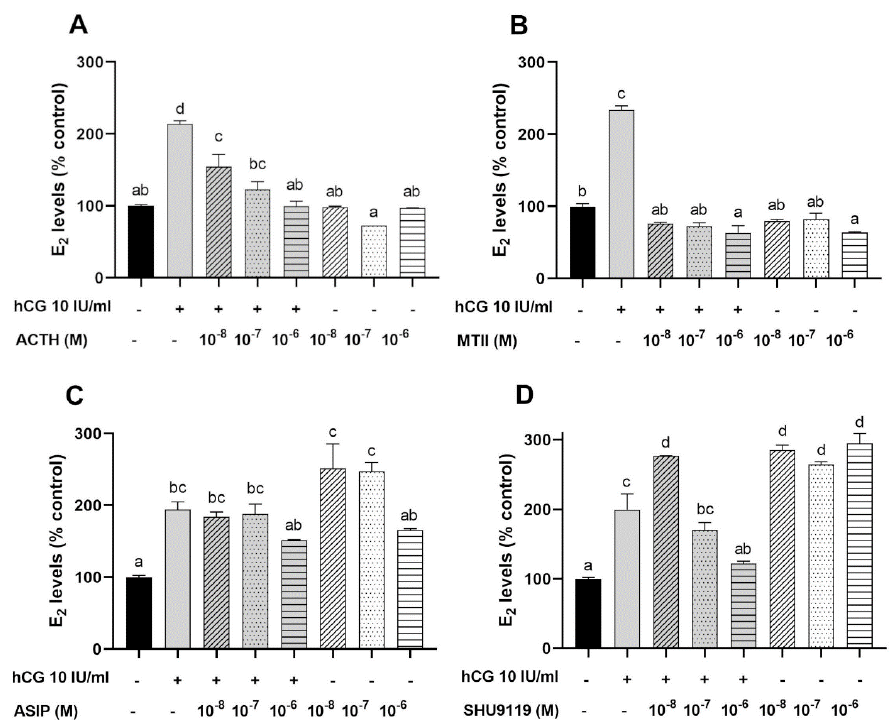
Figure 4. Effects of melanocortin peptides on basal and human chorionic gonadotropin (hCG)- induced estradiol (E2) secretion in previtellogenic and vitellogenic ovarian follicles of zebrafish. ( A ) Effects of ACTH, ( B ) MSH chemical analogues (MTII), ( C ) human ASIP, and ( D ) chemical antagonist (SHU9119). Experiments were performed in triplicate and repeated at least three times. Data is expressed as a percentage of the control (mean ± SEM). Different letters indicate significant variations after a one- way ANOVA analysis, followed by Tukey’s post -hoc test, p < 0.05.